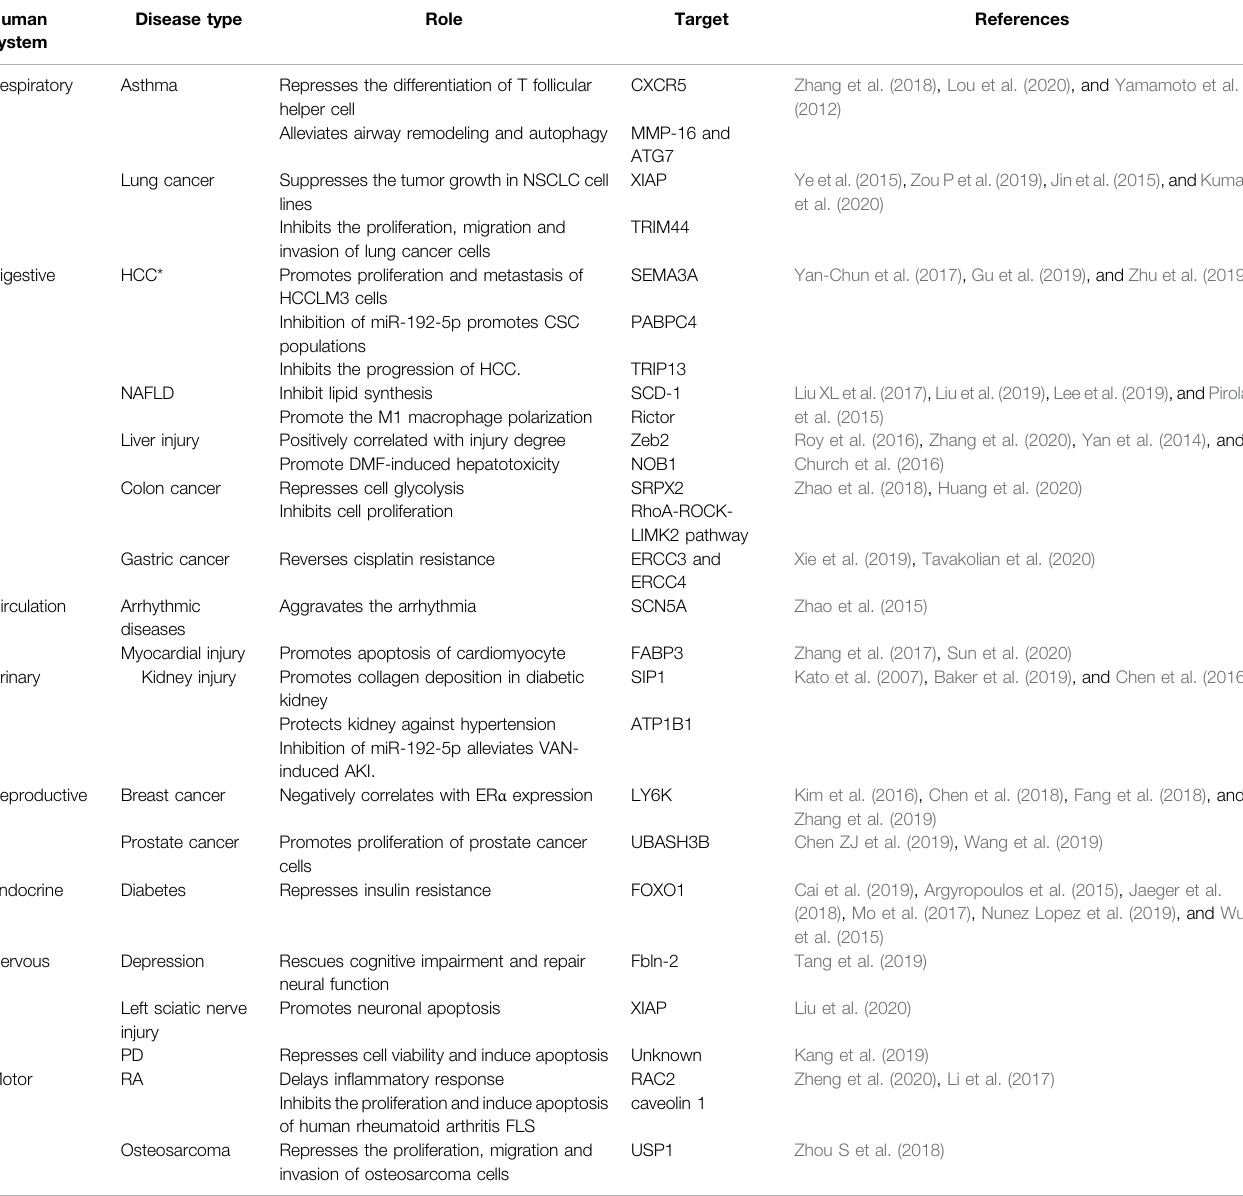
TABLE 1 | MiR-192-5p in different human diseases. The asterisk (*) represents controversial. Human